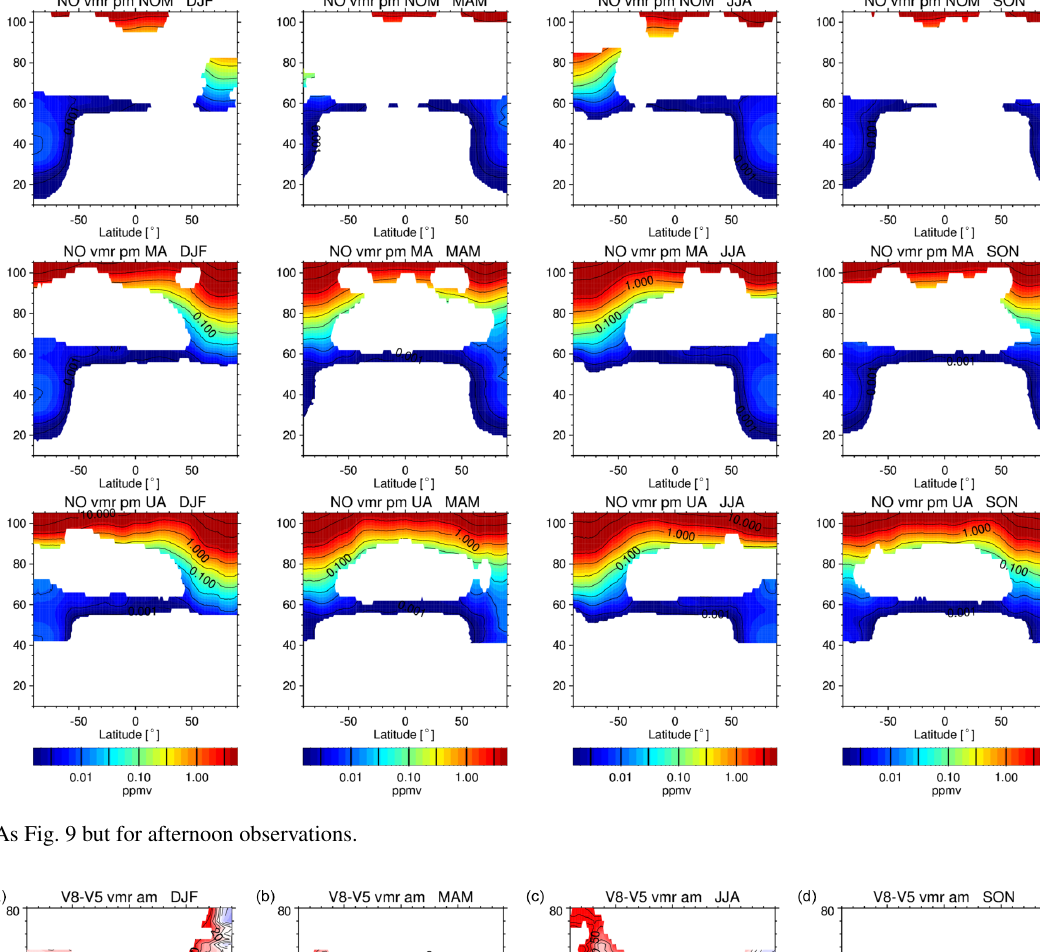
Figure 10. As Fig. 9 but for afternoon observations.